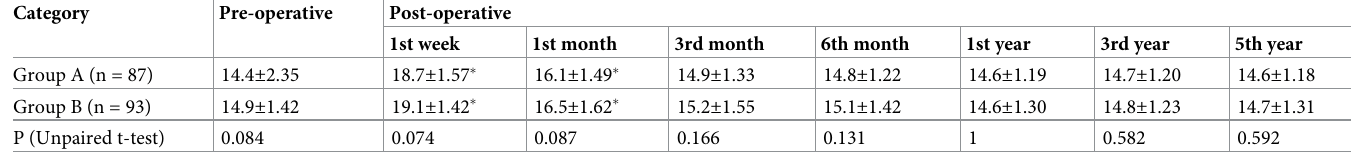
Table 3. Comparison of mean IOP ± SD (mmHg) of Group A (anterior chamber iris-claw fixation) and Group B (retropupillary iris-claw implantation). Category